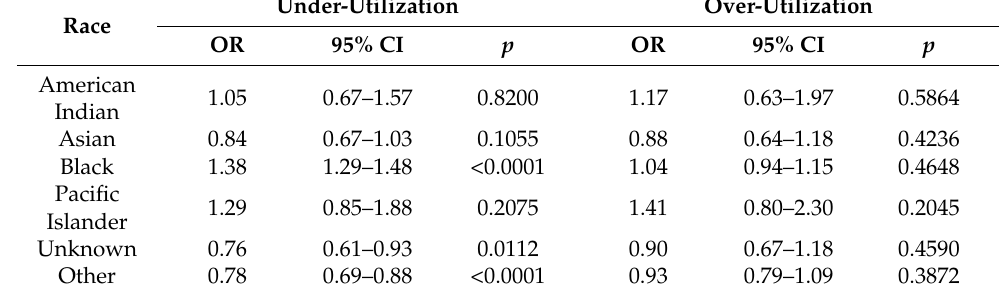
Table 2. Odds ratios for associations between race and over- and under-utilization of the response resource, with White patients representing the reference category.